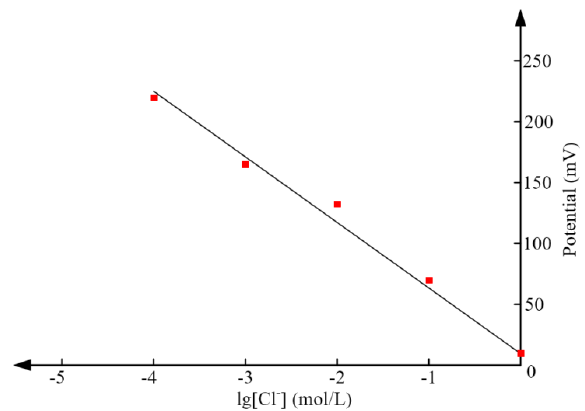
Figure 14. The relationship between electrode potential and chloride concentration.